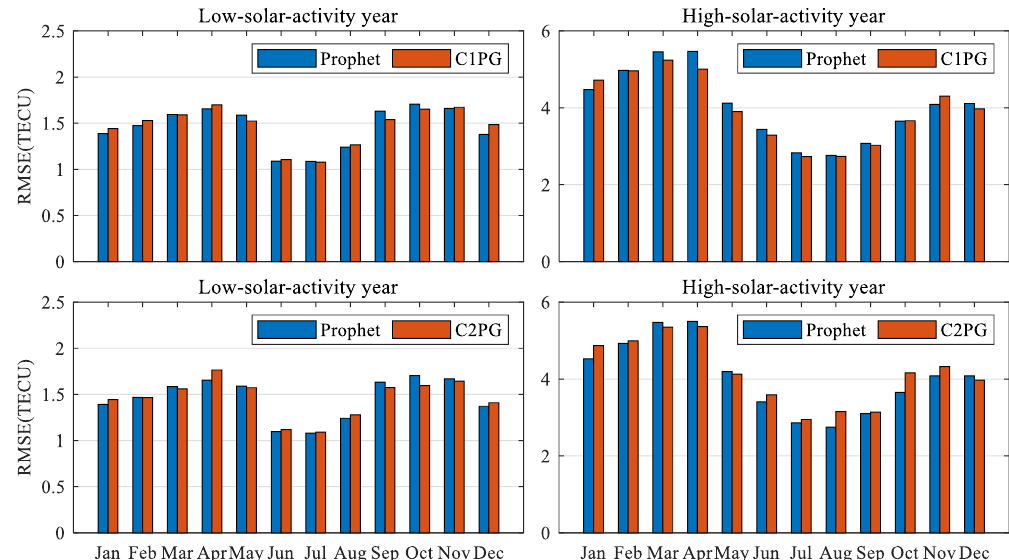
Figure 15. Monthly RMSE statistics of the Prophet model and the COPG values, C1PG and C2PG refer to COPG values forecast for the first and second day. Blue represents the Prophet model, and orange represents the COPG value.